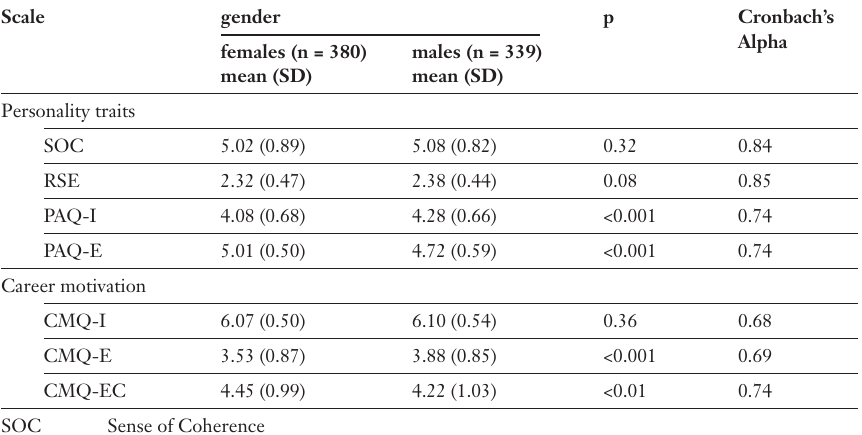
Gender-related means, standard deviations, and Cron- bach’s alphas for the scales of the person- ality-trait question- naires (Sense of Coherence Scale SOC-13, Rosenberg Self-esteem RSE, Personal Attributes Questionnaire PAQ) and the Career Moti- vation Questionnaire scales (CMQ), (n = 719).